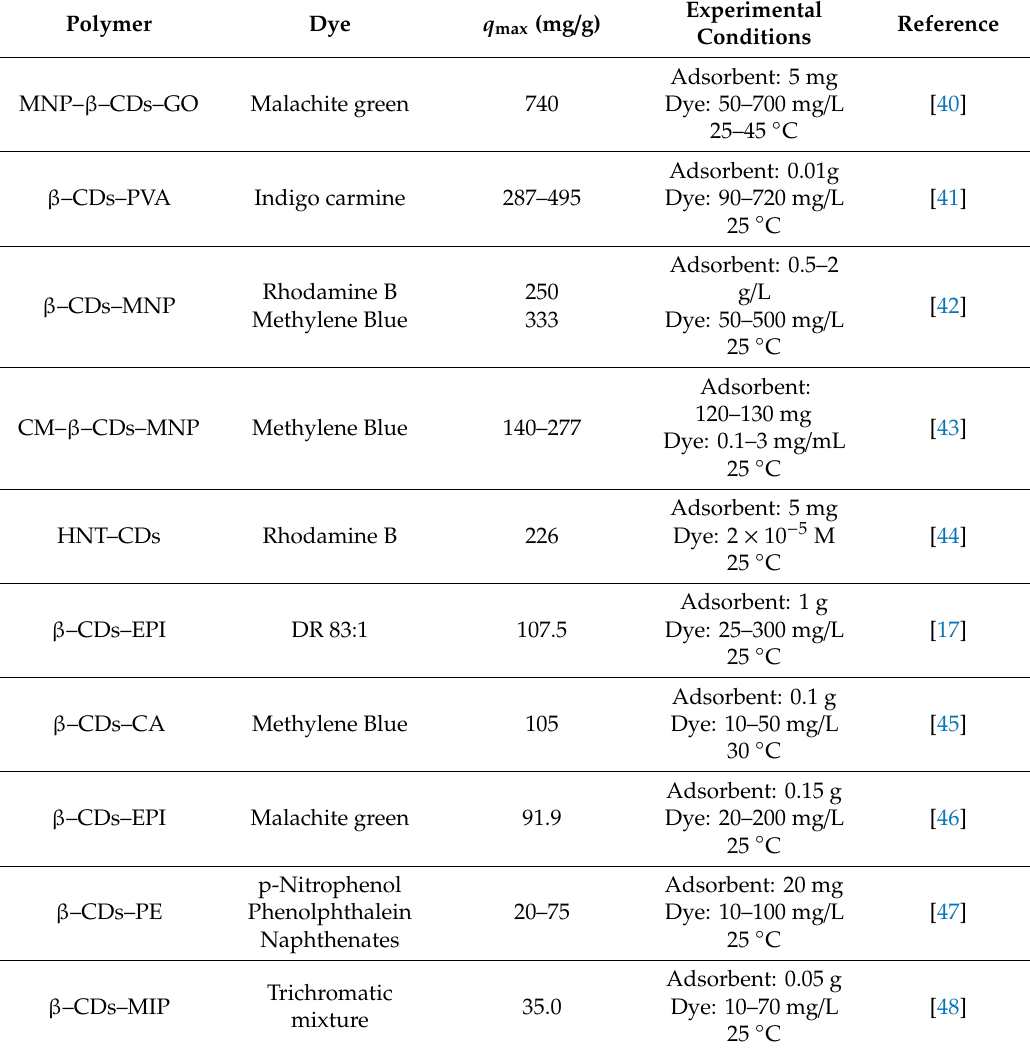
Table 4. E ffi ciency of di ff erent CDs crosslinked polymers in the removal of dyes.